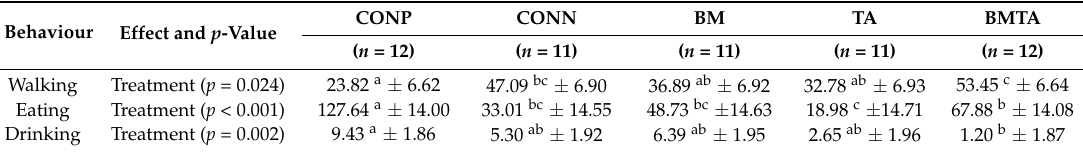
Table 5. Mean duration of time (s) spent walking, eating and drinking by calves in each treatment group within a 5-min focal sample.